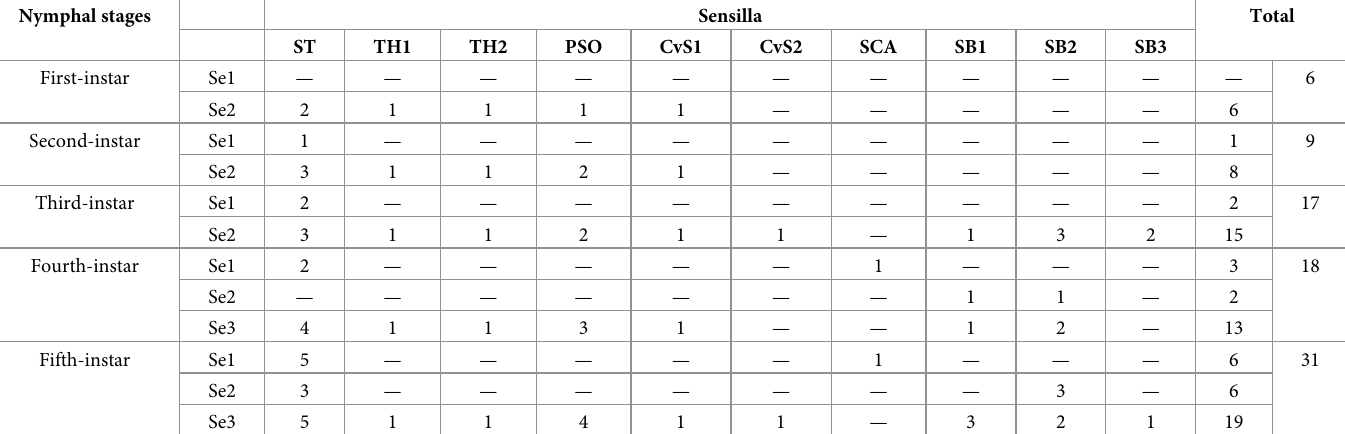
Table 2. Abundance and distribution of sensilla on the antennae of the five nymphal stages of Diaphorina citri . Nymphal stages